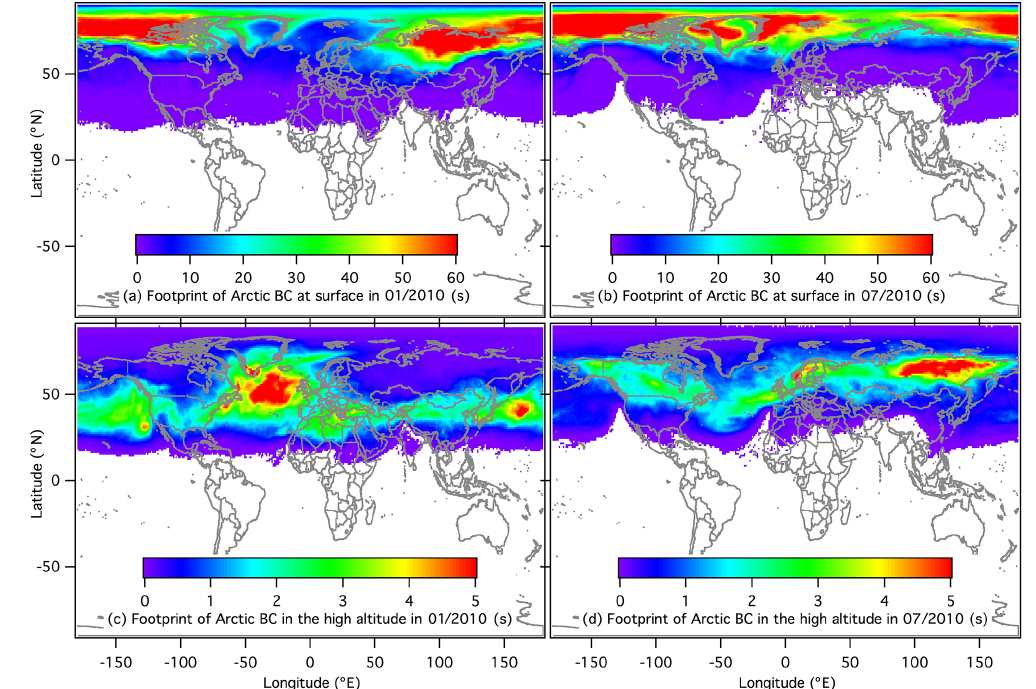
Figure 3. Footprints of Arctic BC shown as retention time(s) of (a) BC at surface (0–500m) in January 2010, (b) BC at surface in July 2010,